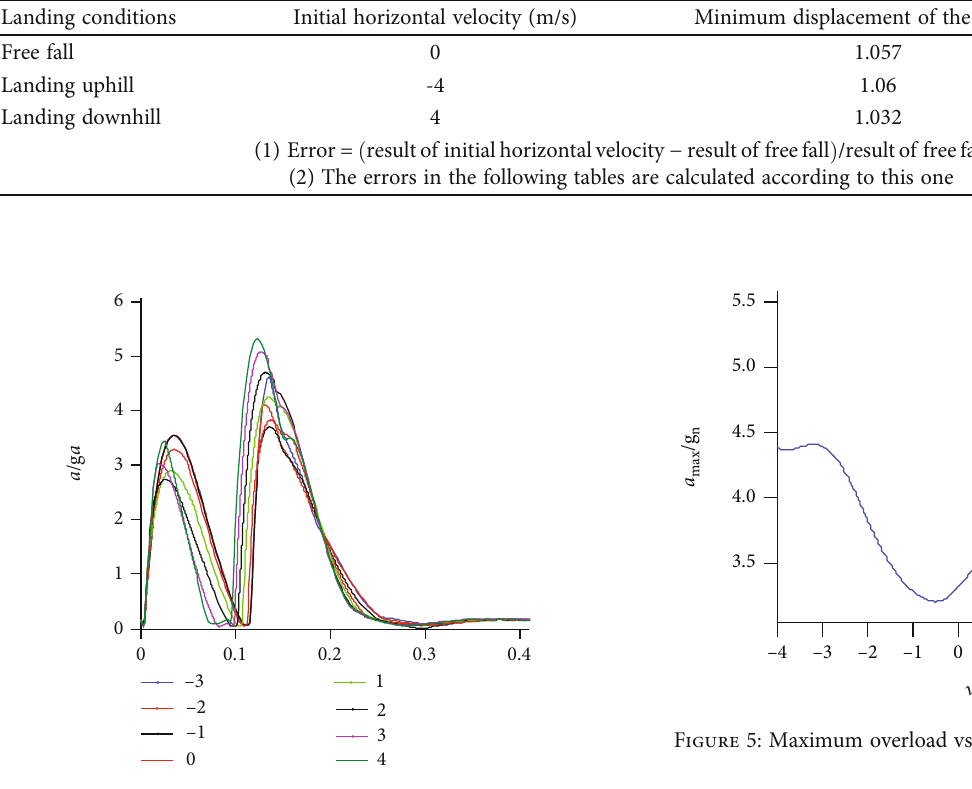
Figure 4: Body overload curve vs. time.